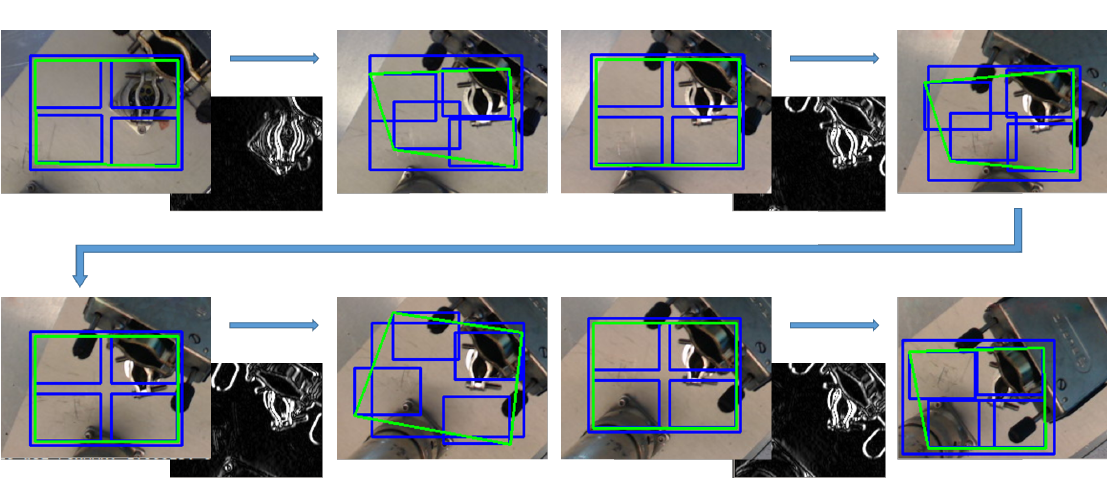
Figure 14. System behavior under partial occlusions.